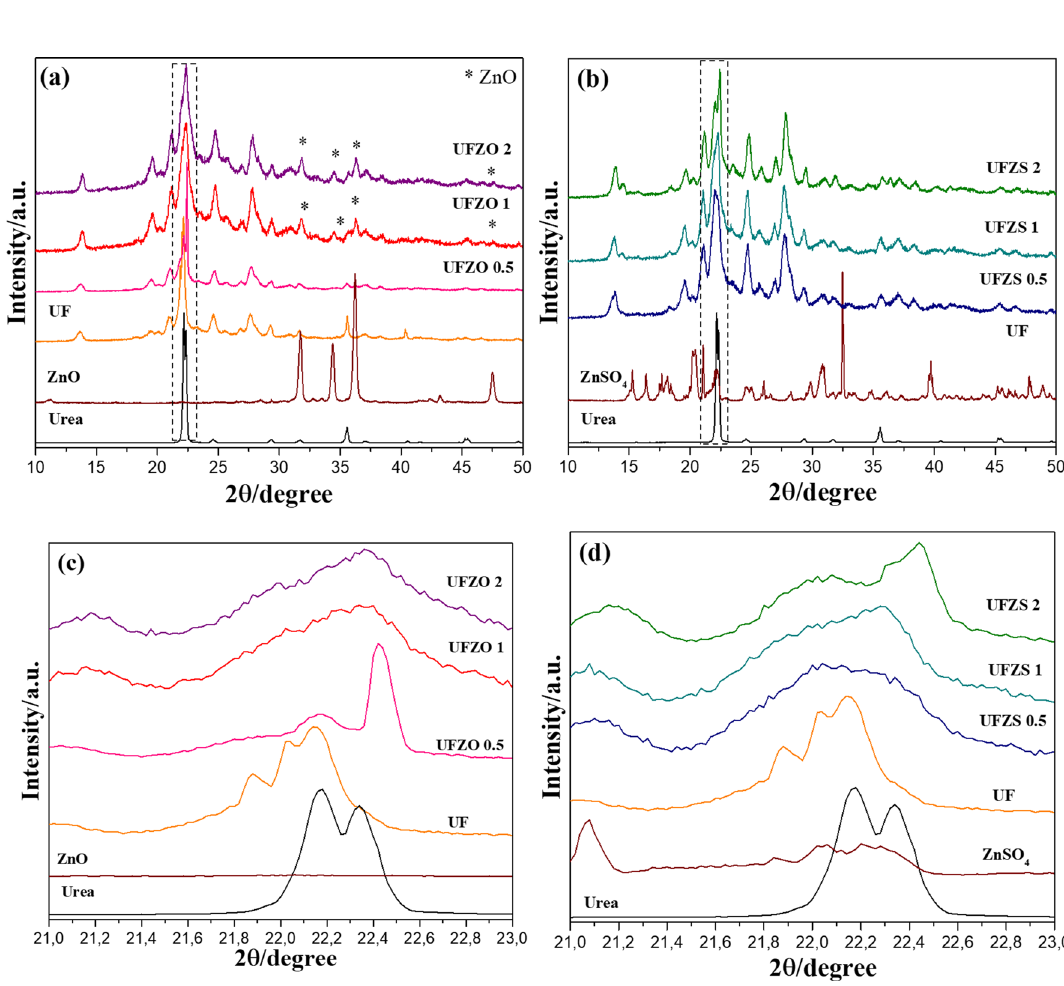
Figure 3. Normalized XRD pattern of Ur and UF with ( a ) ZnO, UFZO 0.5, UFZO 1, UFZO 2, ( b ) ZnSO 4 , UFZS 0.5, UFZS 1 and UFZS 2 ( c , d ) amplification the area at 2θ =